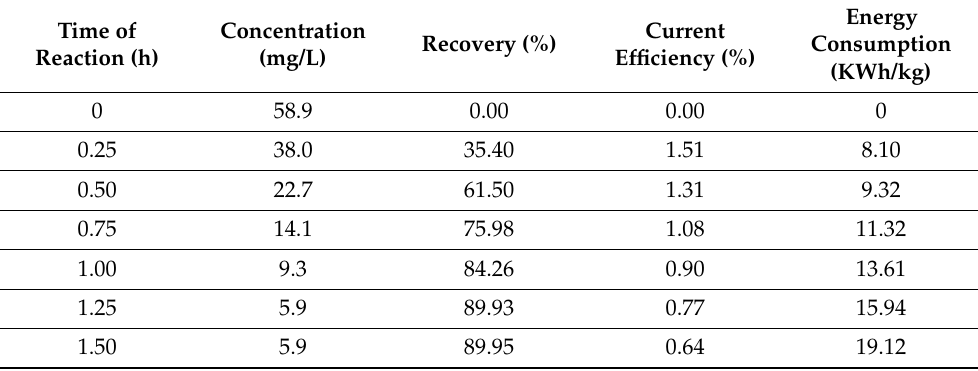
Table 6. Data on Au recovery by electrowinning with Cu cathode and graphite anode. Time of Reaction Energy Time of Concentration Current Recovery (%) Reaction (h) (mg/L) Efficiency (%)